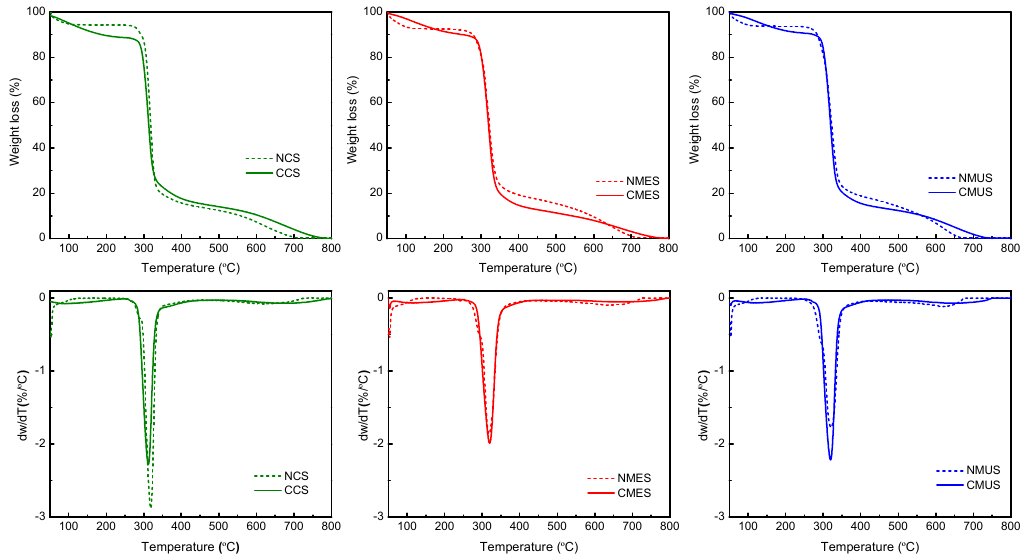
Figure 3. Thermograms of the different graft copolymers and their corresponding native starches. The initial stage of evaporation or loss of moisture is in the range of 50–235 °C, with a percentage of mass loss between 9–11%. Grafted samples exhibit higher values for both parameters compared to their native starches. This is explained by 1) the inclusion in the starch structure of the grafted chains of the PIA, which has functional groups of hydrophilic character, 2) the dehydration of the PIA chains, which leads to formation of polyanhydrides [32,33].